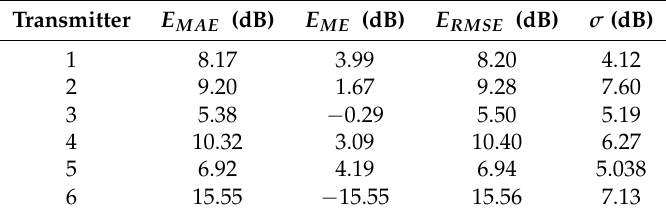
Table 1. Validation results of office environment 1.